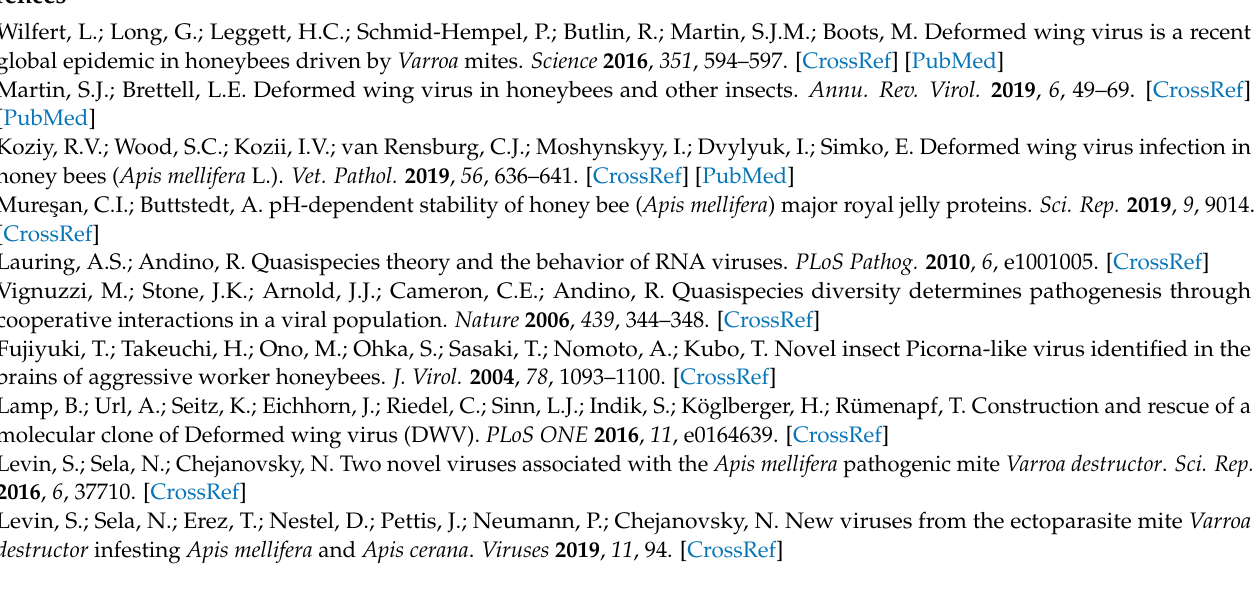
Euvarroa sinhai . Figure S3: Sampling locations of A. florea in Kaohsiung City. Samples collected from the nest and open space are shown in blue and red spots, respectively. Figure S4: Pairwise alignment of DWV helicase encoding domain between ES01TFS11 and AF01T243. Table S1: